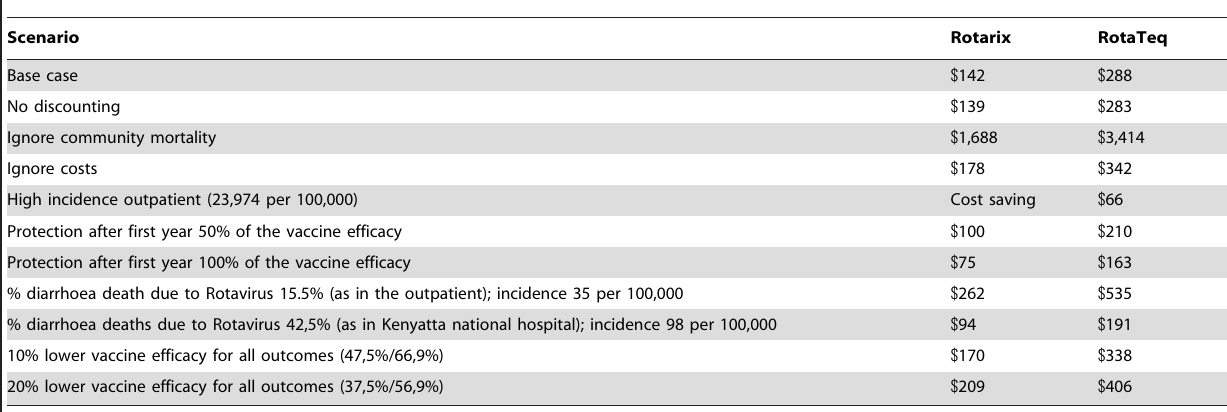
Table 4. Scenario sensitivity analysis.